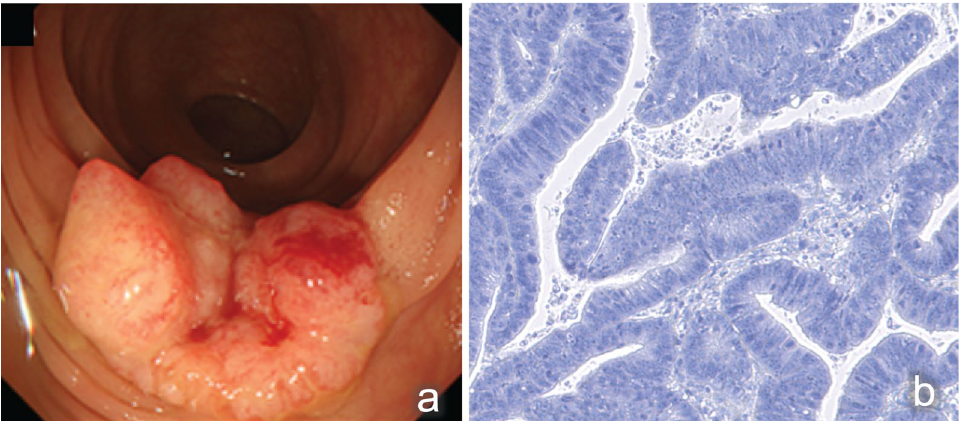
Fig. 1 Initial examination findings of colonoscopy. a Type II tumor, measured 30 mm in diameter and located in the transverse colon. b The biopsy specimen demonstrated a well-differentiated